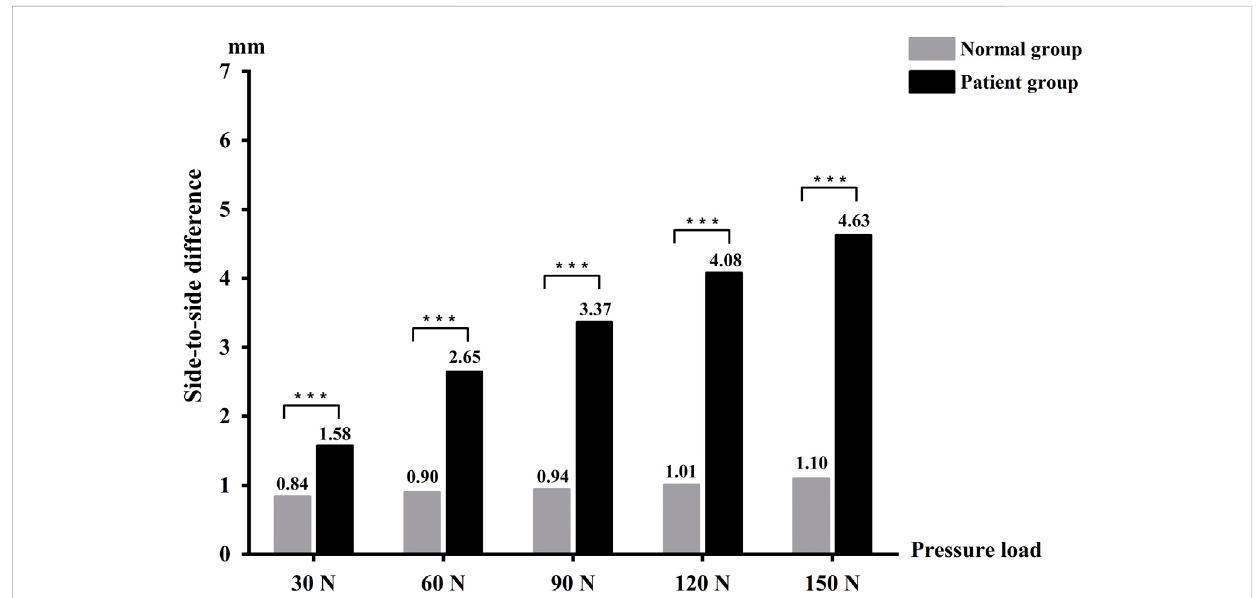
FIGURE 4 The side-to-side difference between the two groups in anterior knee laxity measured by the Ligs Digital Arthrometer.